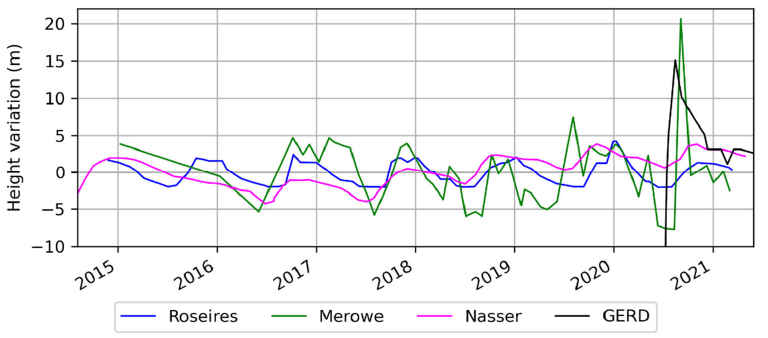
Figure 7. Comparison of height variations in all four reservoirs, including the Millennium Reservoir. The height variation was obtained by subtracting the mean water level height for each reservoir. The mean water level heights were 176 m for Lake Nasser, 294 m for Lake Merowe, 492 m for Lake Roseires, and 605 m for Millennium